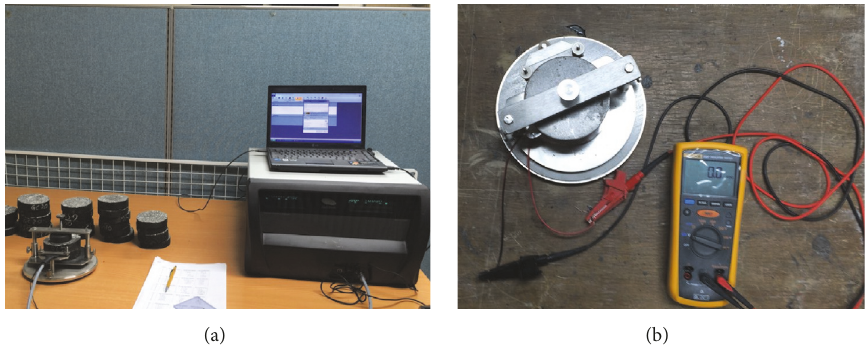
Figure 1: Measuring devices: (a) thermal constant analyzer and (b) resistance tester.